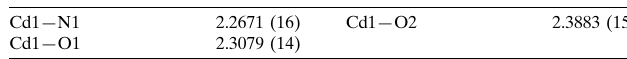
Selected bond lengths (A˚ ).